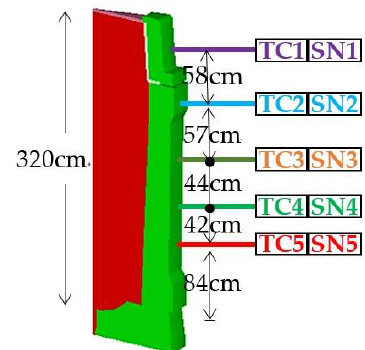
Figure 2. The used 3D model and the installation positions of thermocouples (TC) for experiment and sensors (SN) for simulations.